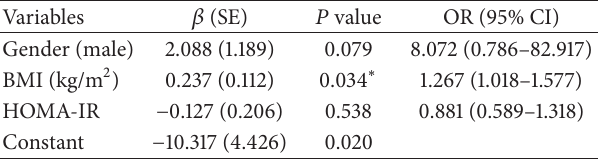
Table 10: Model for predicting ≥ 2 mixed nerves involved (Model